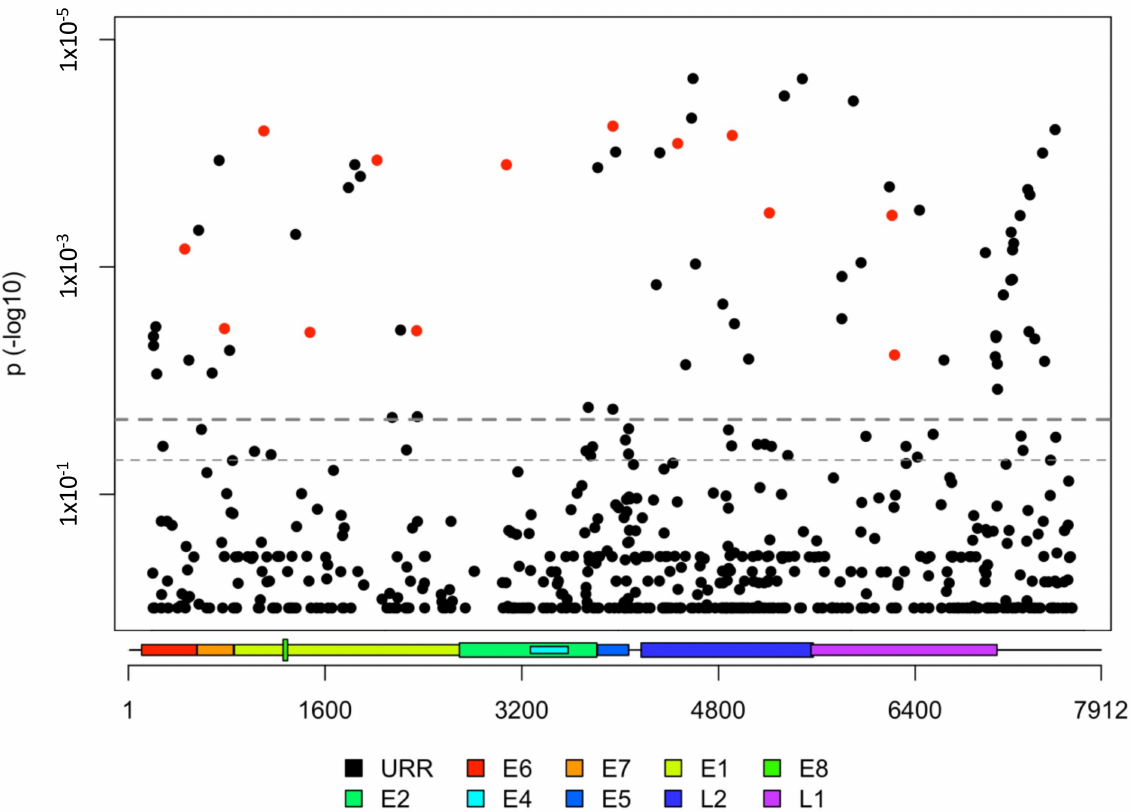
Figure 2. HPV31 viral genome wide association analysis and SNPs associated with CIN3+ in the PaP Cohort. Red circles indicate the 13 nonsynonymous SNPs significantly different between cases and controls after false discovery rate (FDR) correction for multiple comparisons. Dashed thicker line represents the FDR significance threshold. Dashed thinner line represents the logistic regression 0.05 significance threshold. y -axis represents p -values in logarithm scale. x -axis represents HPV31 genome positions and viral gene regions indicated by the colored key below the